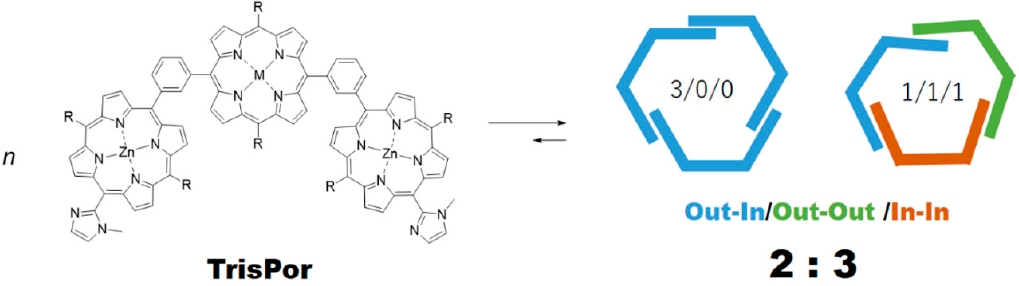
Figure 7. TrisPor gives two possible conformational isomers, which can be assigned in 1 H-NMR spectra.